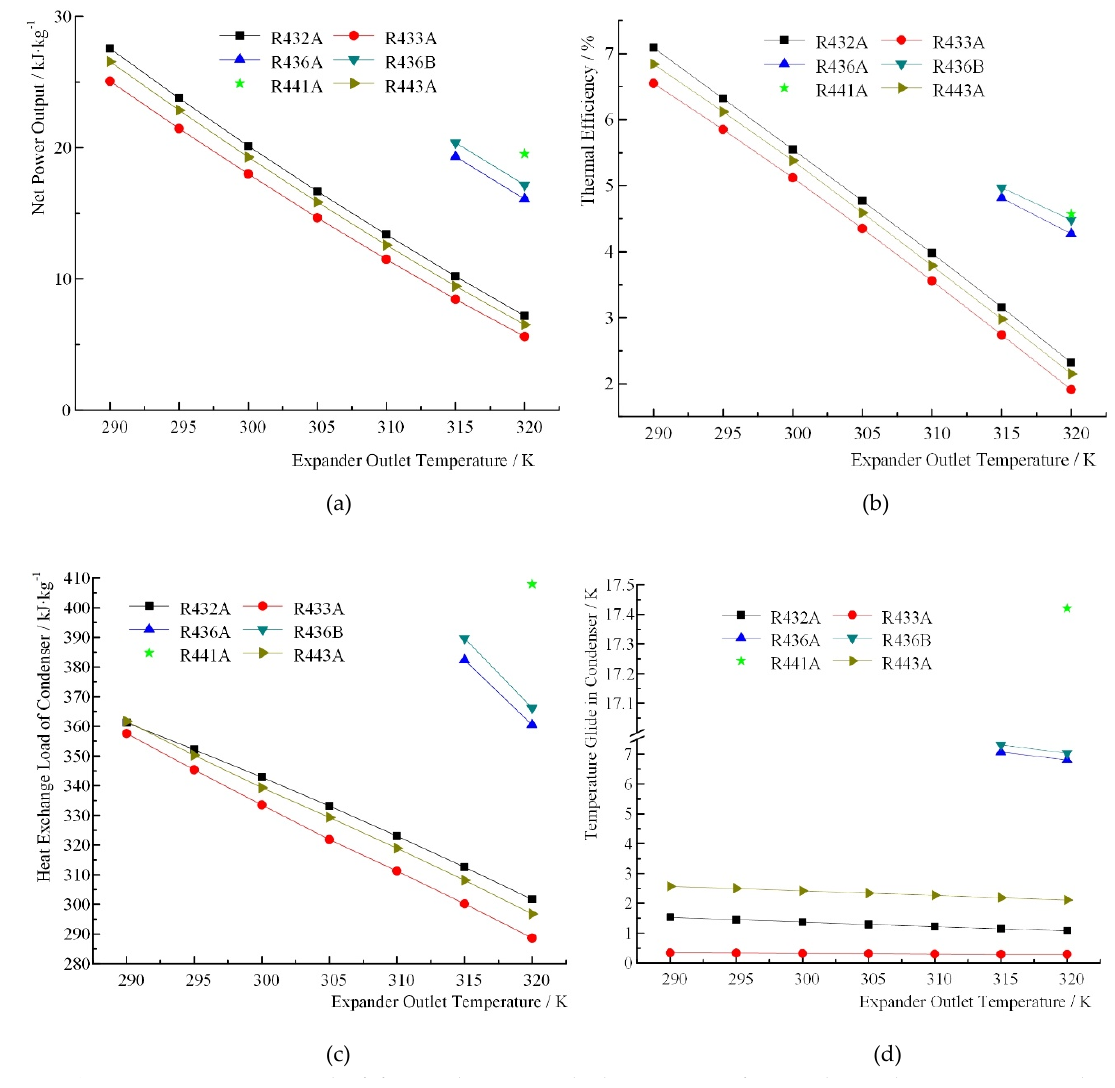
Figure 10. Variation trend of four indicators with the increase of expander outlet temperature when considering isentropic efficiency of expander: (a) net work; (b) thermal efficiency; (c) heat exchange load of condenser; (d) temperature glide in condenser.